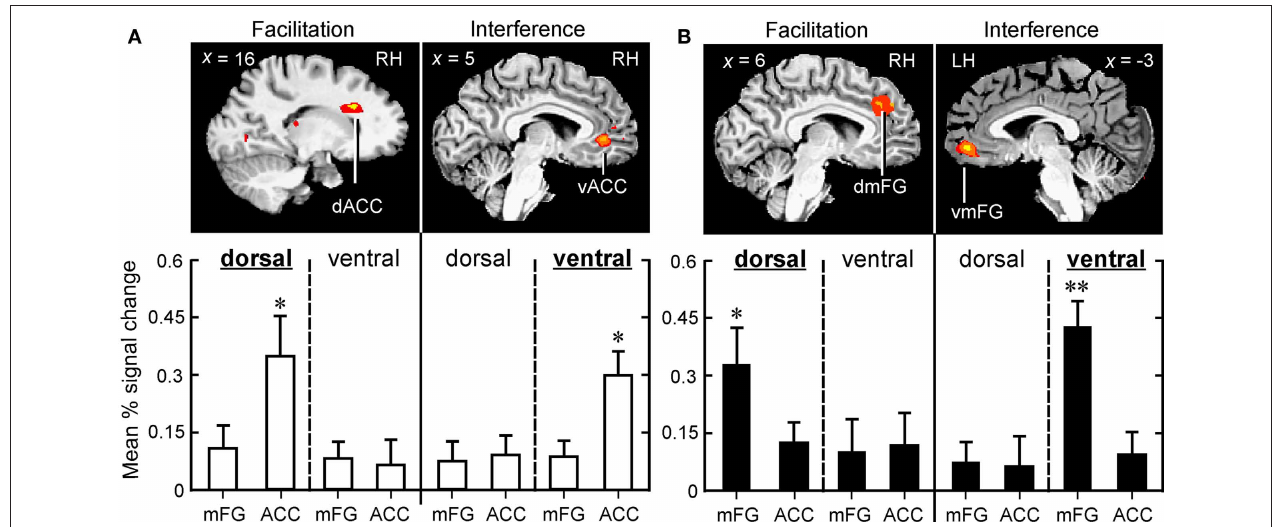
ventral regions (Interference). In the VOICE task (open bars), significantly greater activity was found in dACC (facilitation) and vACC (interference; * p < 0.01), whereas in the SEMANTIC task (solid bars), peak activity was found in dmFG (facilitation; * p < 0.01) and vmFG (interference; ** p < 0.001). Same abbreviations as in Figure 3 .